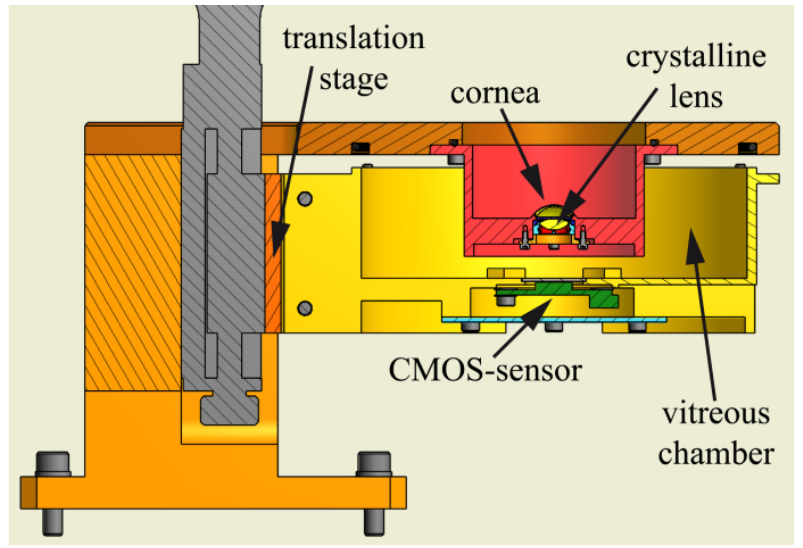
Figure 17. Sectional drawing of the model presented by Ackermann et al. Biomedical Optics Express 2013, 4, 220 ([45]). Originally published by and reprinted with permission from Optica Publishing Group.